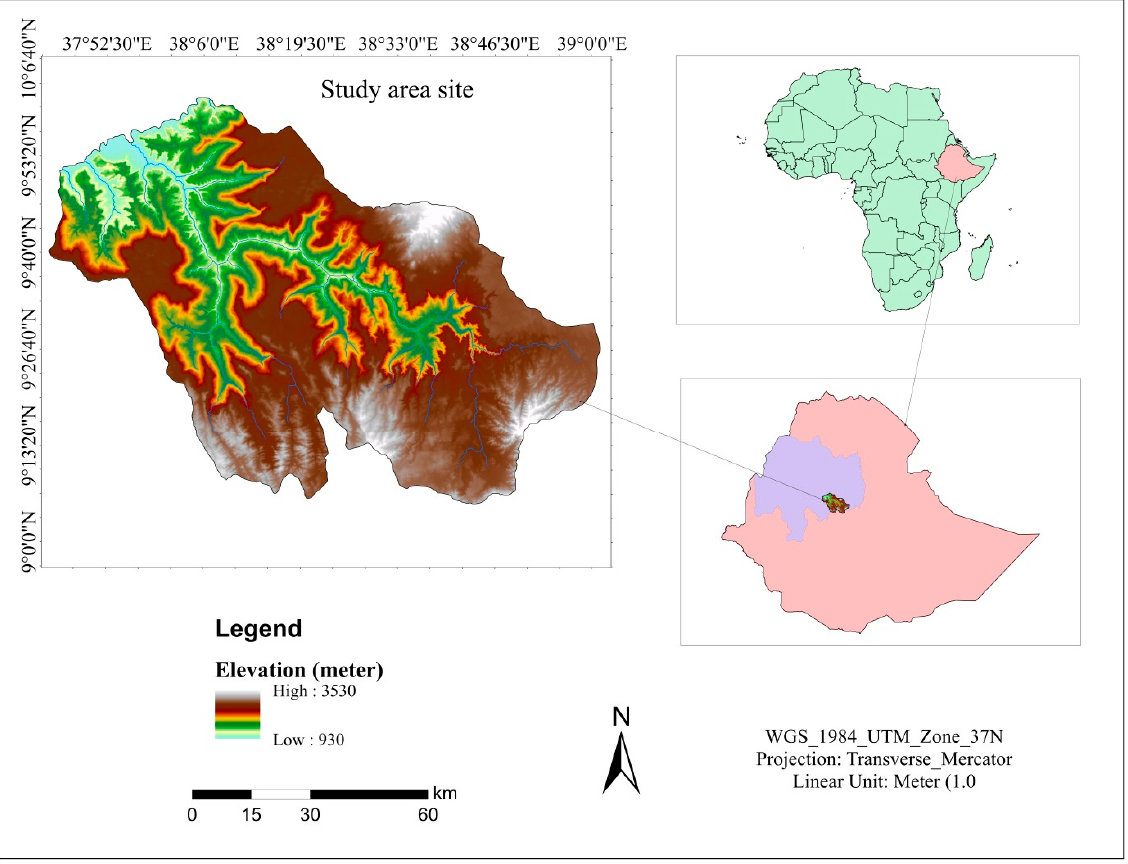
Figure 1. Map of the study area.